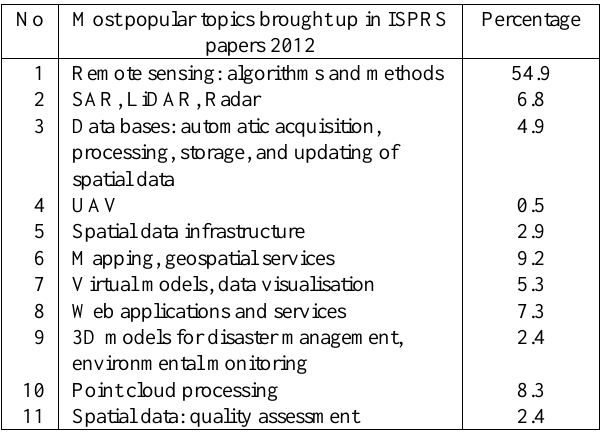
Table 3. Frequency of publications devoted to particular topics in the ISPRS materials 2012